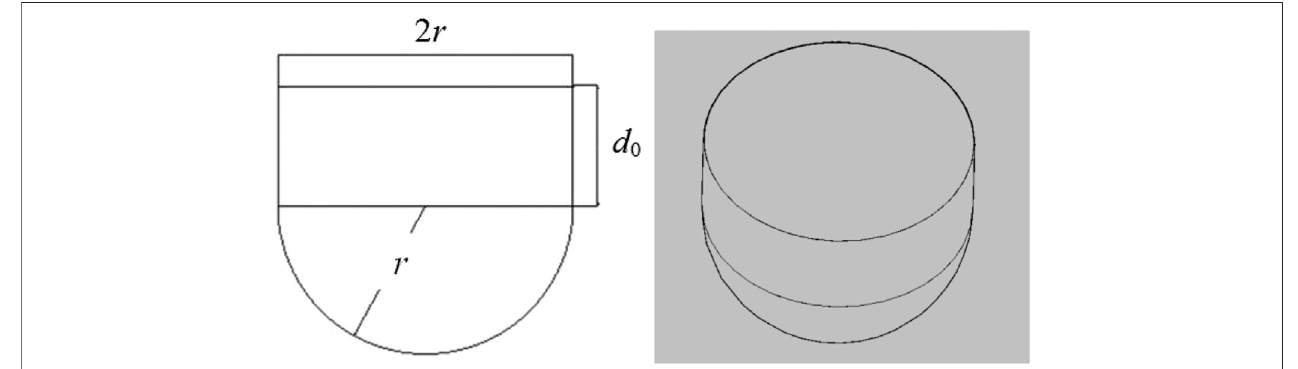
Figure 6 | Schematic diagram of submerged part of hemispherical bottom cylindrical WEC.